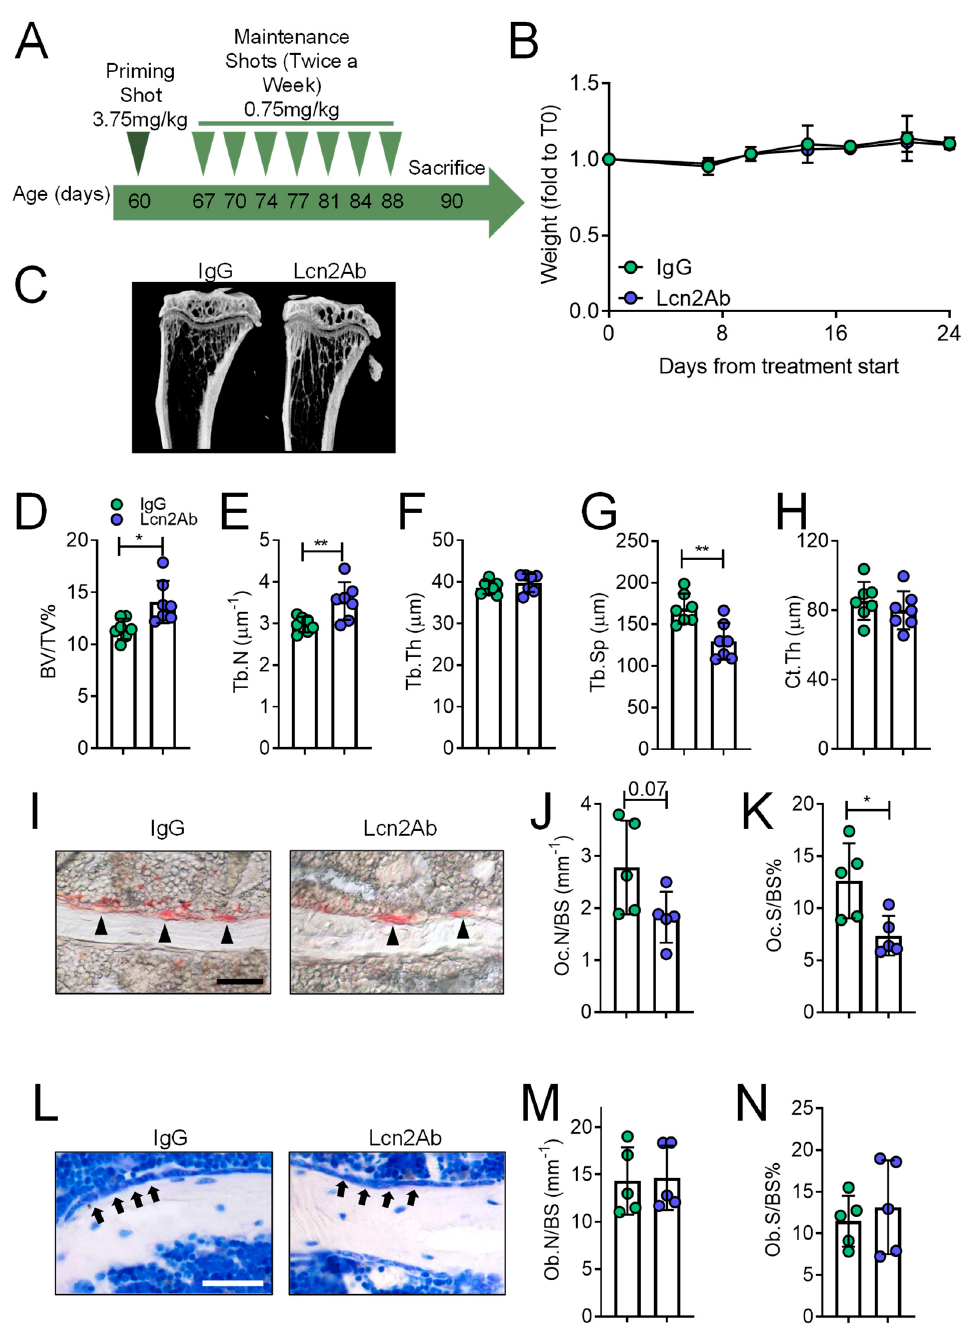
Masson’s trichrome-stained muscle sections. ( J ) ELISA assay to quantify serum creatine kinase (CK). Results are the mean ± SD of at least three mice/group; * p < 0.05, *** p < 0.001, and **** p < 0.0001 between the indicated groups. One-way ANOVA .